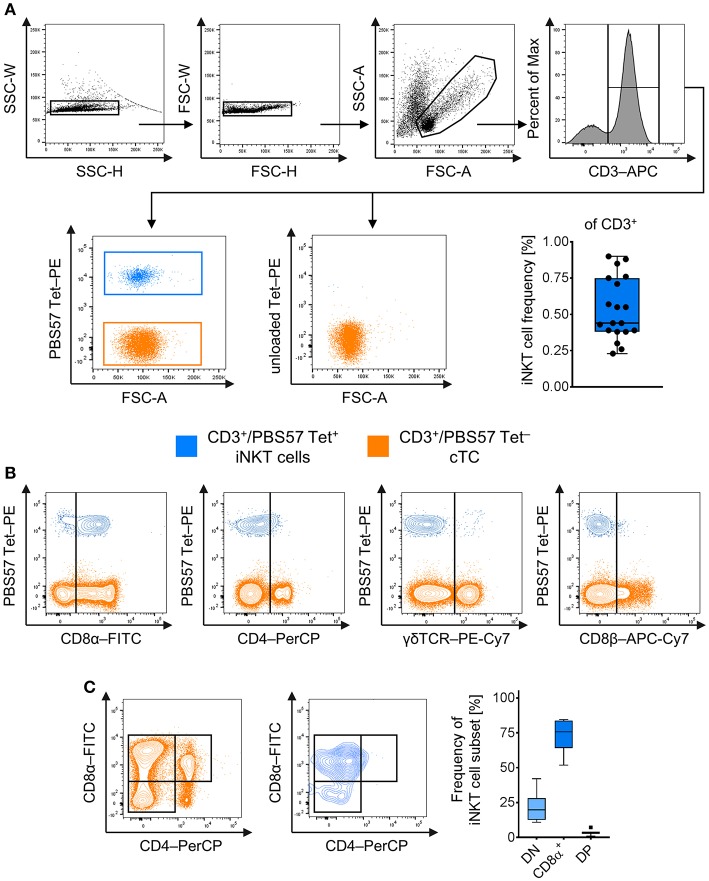
Identification and phenotype of naïve peripheral porcine iNKT cells. Expression of surface markers was analyzed by flow cytometry. (A) Doublets were excluded by SSC-W vs. SSC-H gates, followed by FSC-W vs. FSC-H gates. Live lymphocytes were identified according to their FSC/SSC characteristics. All T cells were identified using antibodies against CD3. CD3+ T cells stained with the PBS57-loaded CD1d tetramer (left plot) were defined as invariant Natural Killer T cells (iNKT; blue), tetramer-negative cells were defined as conventional T cells (cTC; orange). Unloaded tetramers served as control (right plot). Frequency of iNKT cells in peripheral blood among CD3+ lymphocytes shown as Tukey box plot (n = 19). (B) Evaluation of expression of CD8α, CD4, γδTCR, and CD8β on iNKT cells and cTC. Representative plots of at least four experiments are shown. (C) Representative plots of CD8α and CD4 co-expression by cTC and iNKT cells. CD8α−/CD4− (DN; light blue), CD8α+/CD4− (CD8α+, blue), and CD8α+/CD4+ (DP; dark blue) subsets among iNKT cells were identified according to their expression pattern in cTC. Frequency of iNKT cell subsets shown as Tukey box plots (n = 7).